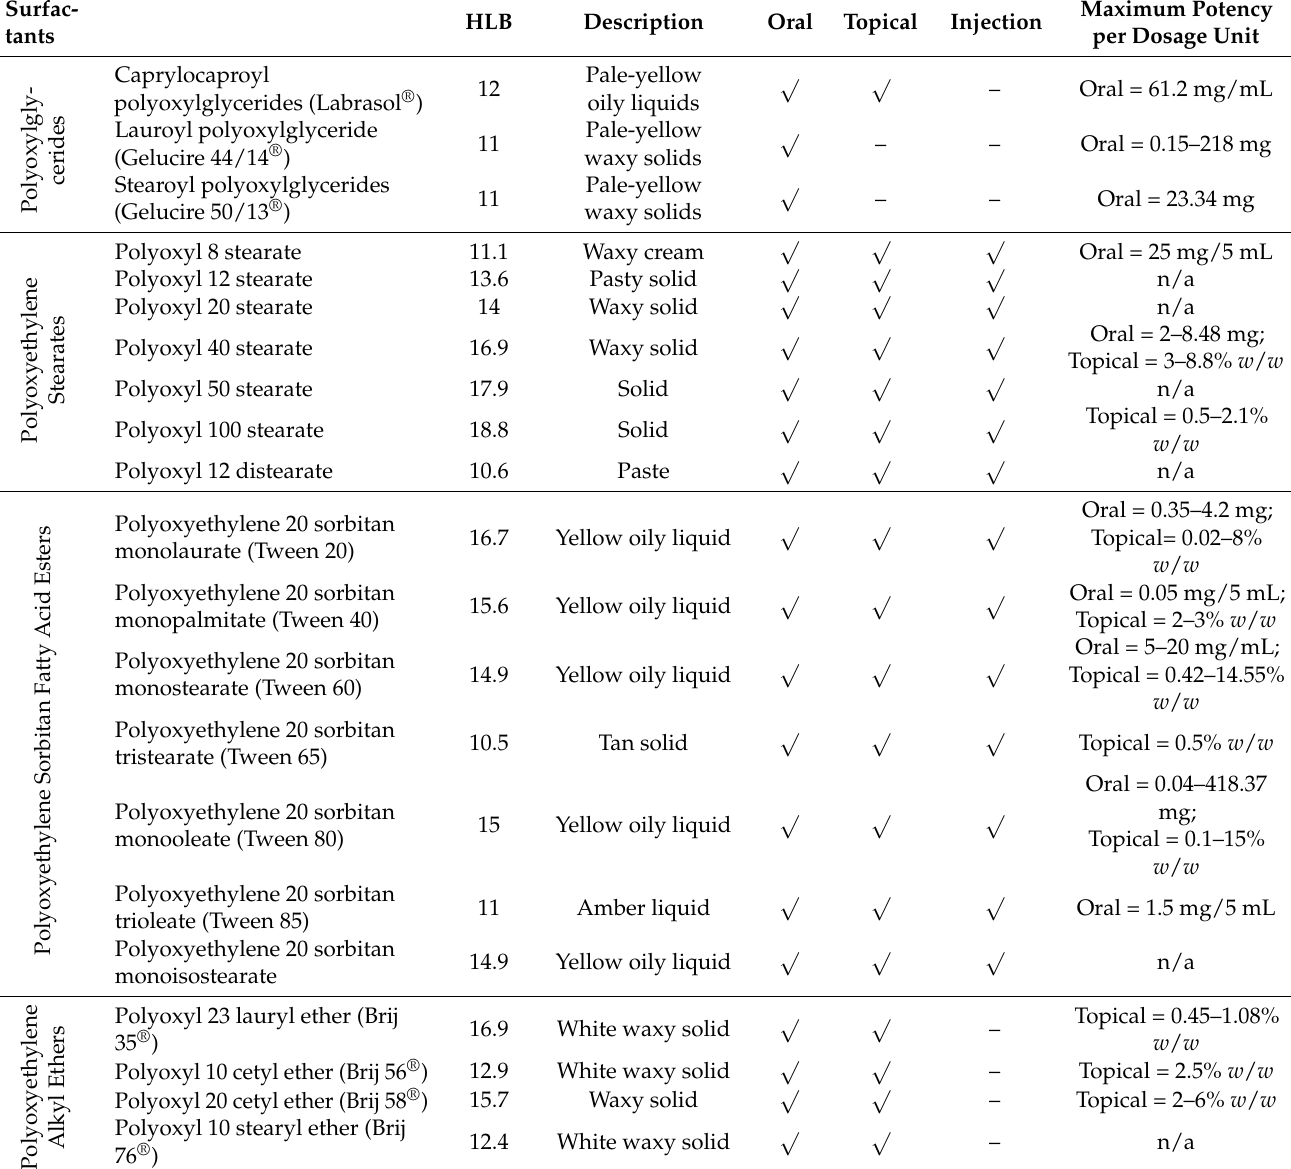
Table 3. Approved nonionic surfactants by the FDA and their descriptions, along with each latest maximum potency per dosage unit per 20 October 2022 [27]. The n/a refers to data not available for the corresponding